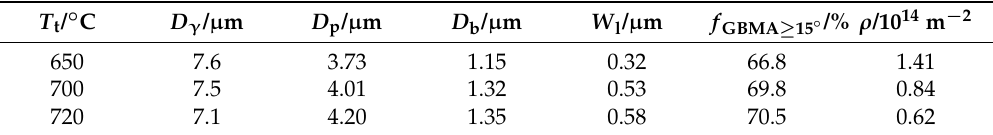
Figure 6. Typical prior austenite grain (PAG) observation of as-quenched sample at 890 ° C . Table 2. Quantitative determinations of PAG and martensitic substructure features in Q&T–treated samples at differing T t .